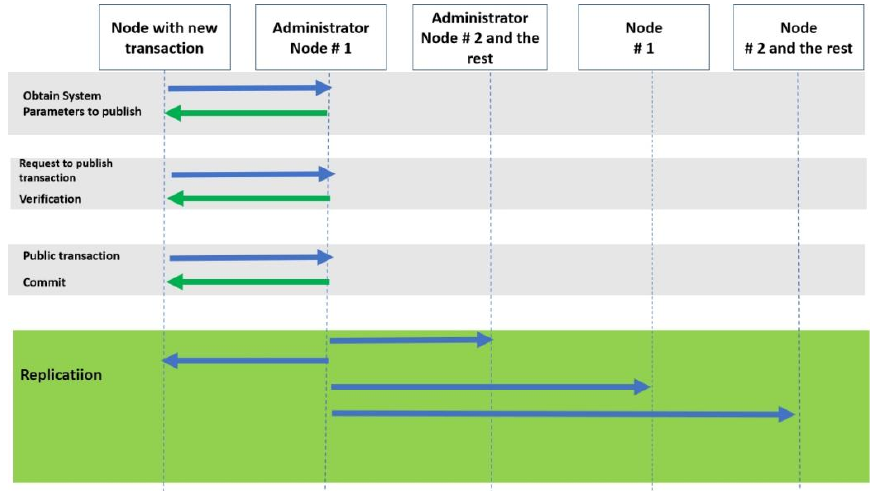
Figure 5. Process flow of transaction data replication in IoT blockchain.